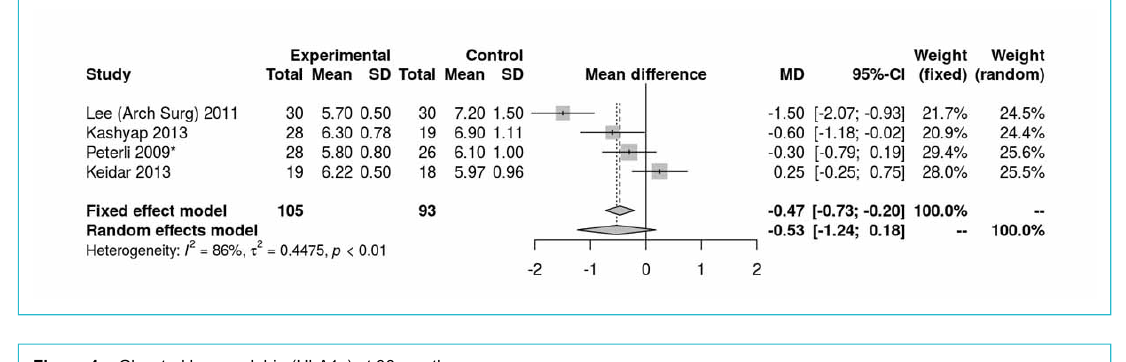
Figure 4c: Glycated haemoglobin (HbA1c) at 36 months.